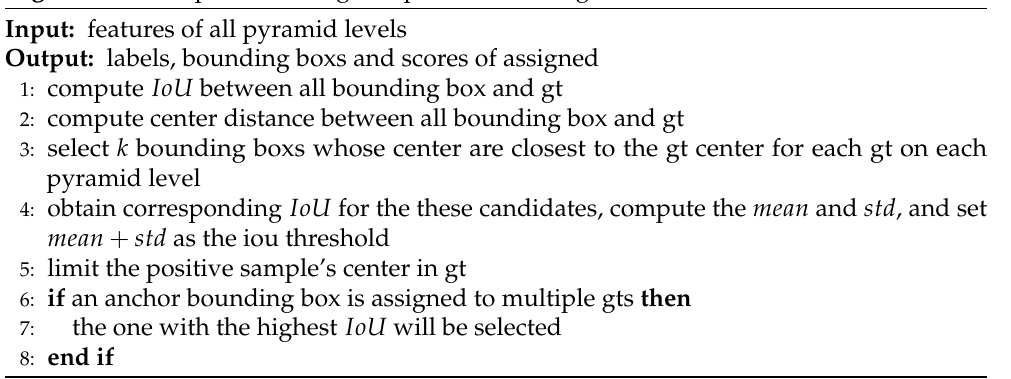
Algorithm 1 Adaptive Training Sample Selection Algorithm